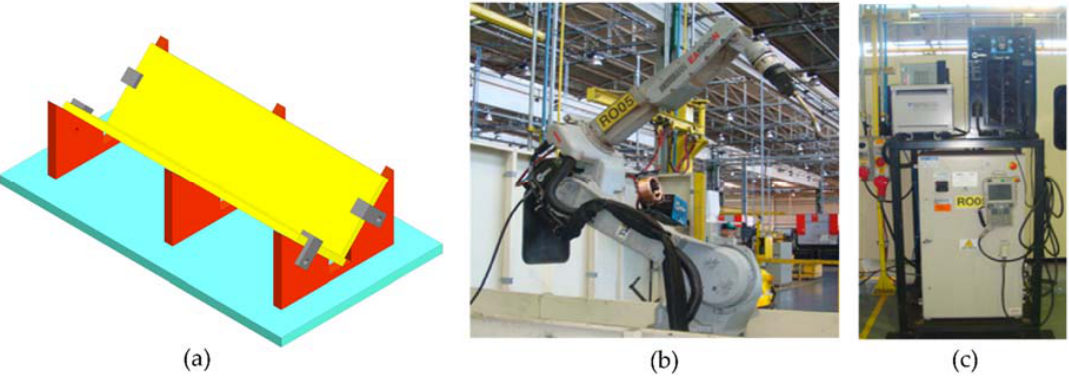
Figure 1. ( a ) Device for positioning plates; ( b ) Yaskama MA 1900 robot and ( c ) Auto-Axcess 450 power supply.